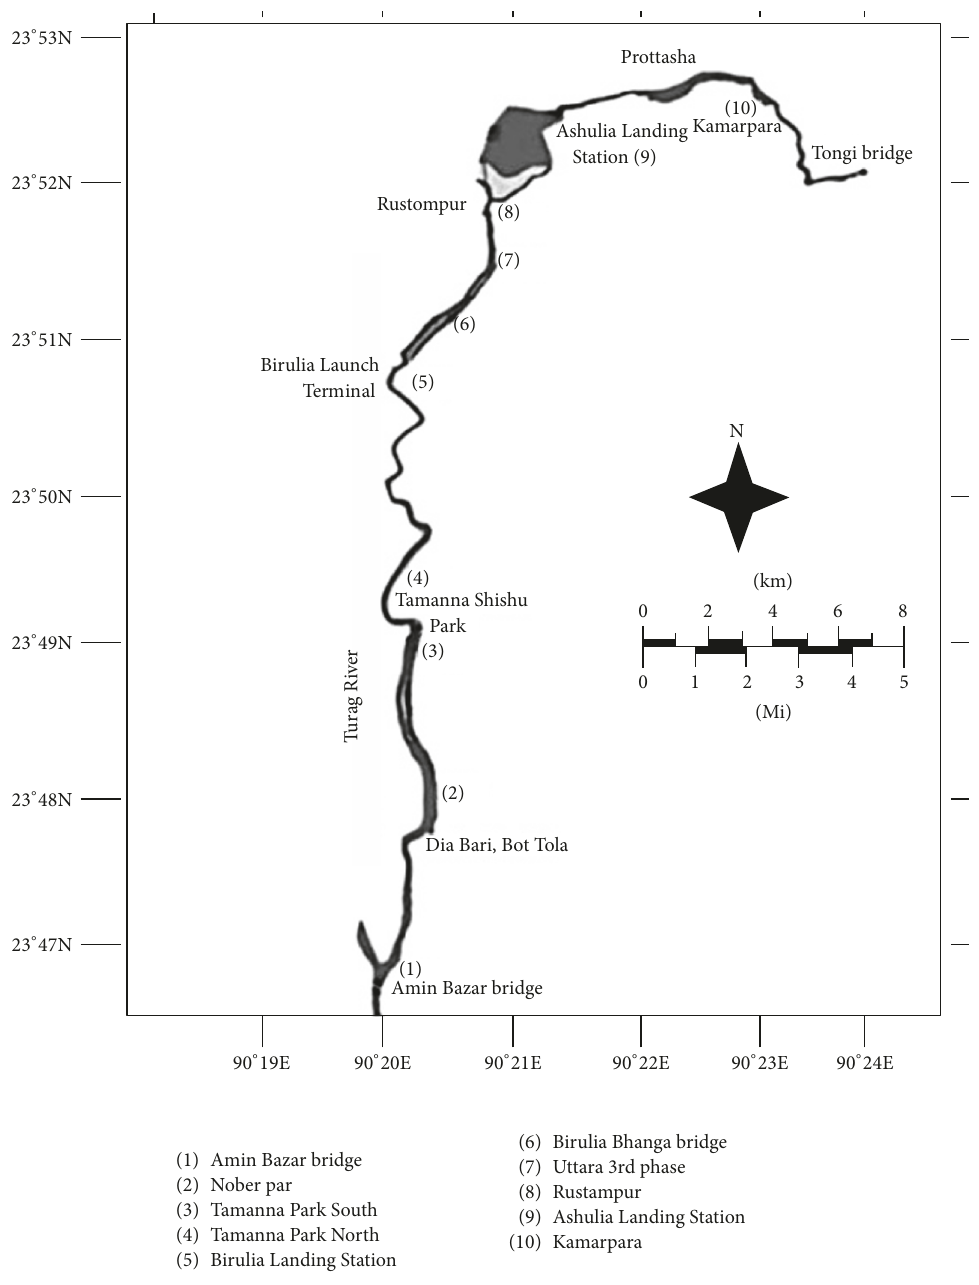
Figure 1: Map of the Turag